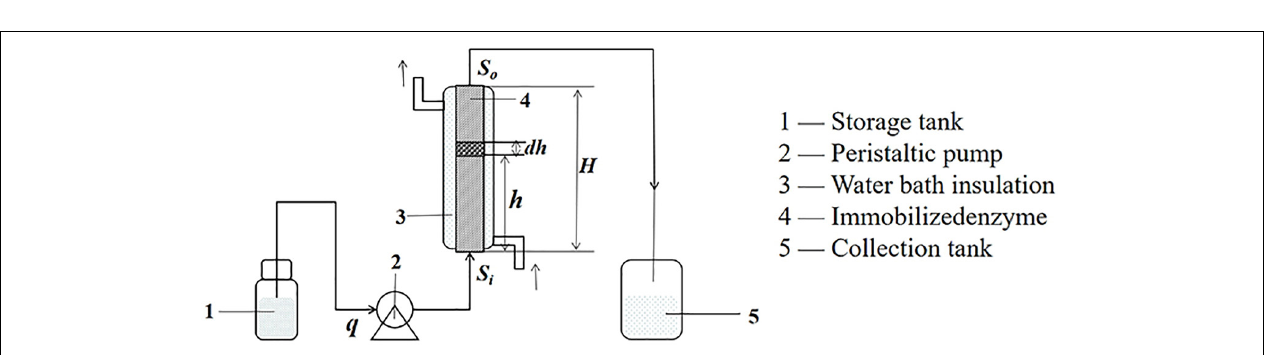
FIGURE 7 | The structure diagram of an enzyme